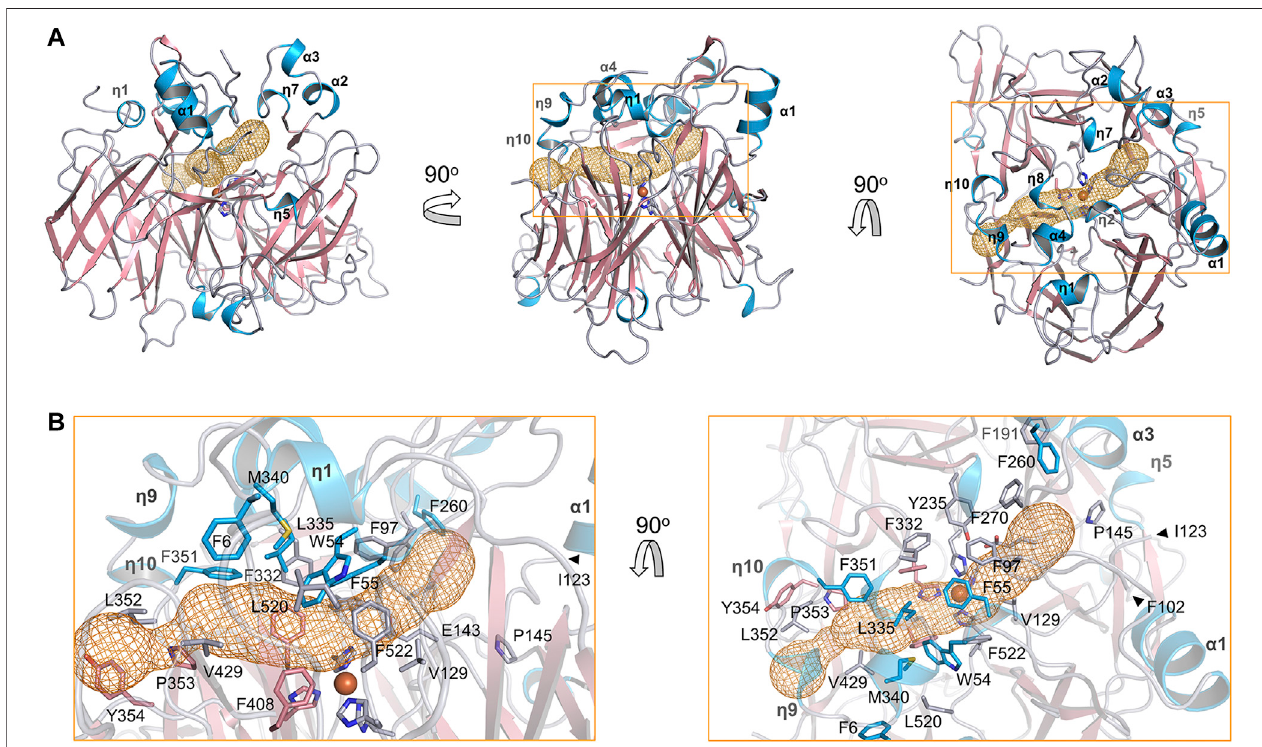
FIGURE 5 | Substrate tunnel of BCMO-2. (A) Ribbon representation of BCMO-2 and mesh representation of the tunnel. The color scheme is as in Figure 3 . Box denotes the zoomed region shown in B. (B) Zoomed-in view of the tunnel. Ribbons are in transparence; side chains of Phe6, Trp54, Phe55, Phe97, Val129, Glu143,